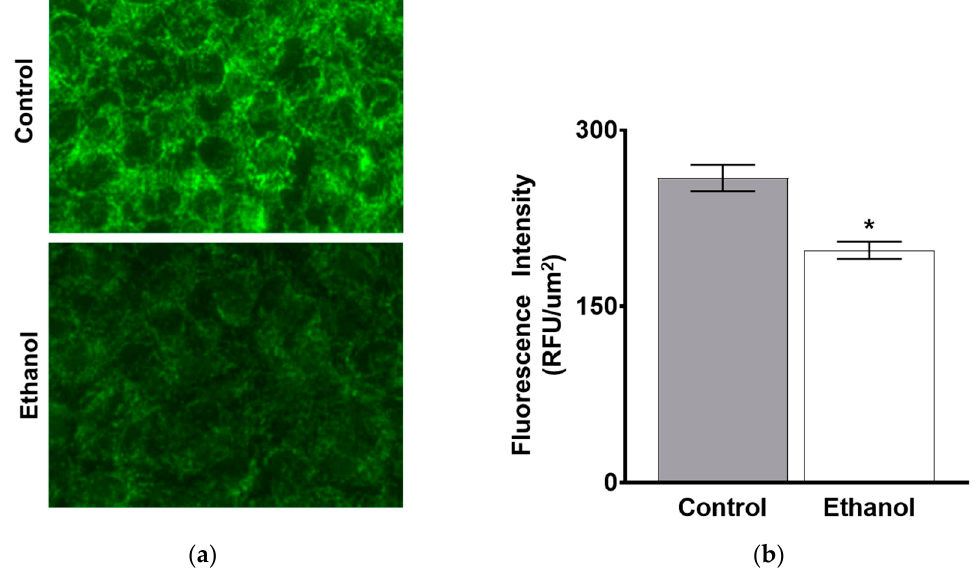
Figure 9. One hour of moderate ethanol significantly decreased B0AT1 immunofluorescence intensity in IEC-18 cells. ( a ) Shown are representative images taken using a 60 × objective. The green stain represents B0AT1. ( b ) Quantification of B0AT1 immunofluorescence intensity. Each sample is an average of five di ff erent images obtained using a 20 × objective. The error bars represent the SEM (* p < 0.05, n =